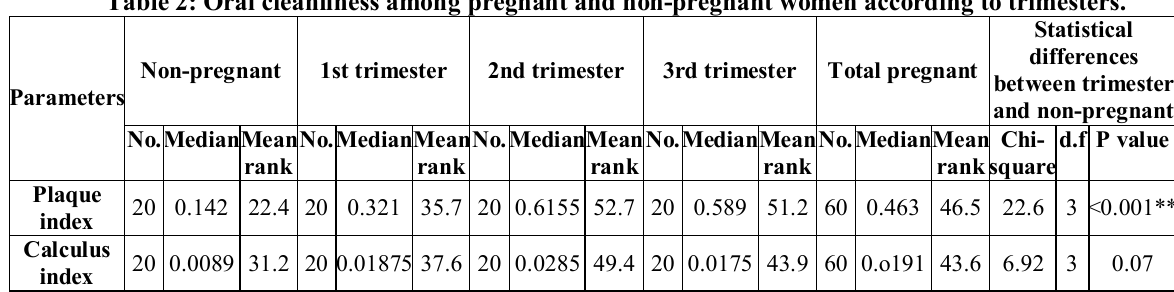
Table 2: Oral cleanliness among pregnant and non-pregnant women according to trimesters.